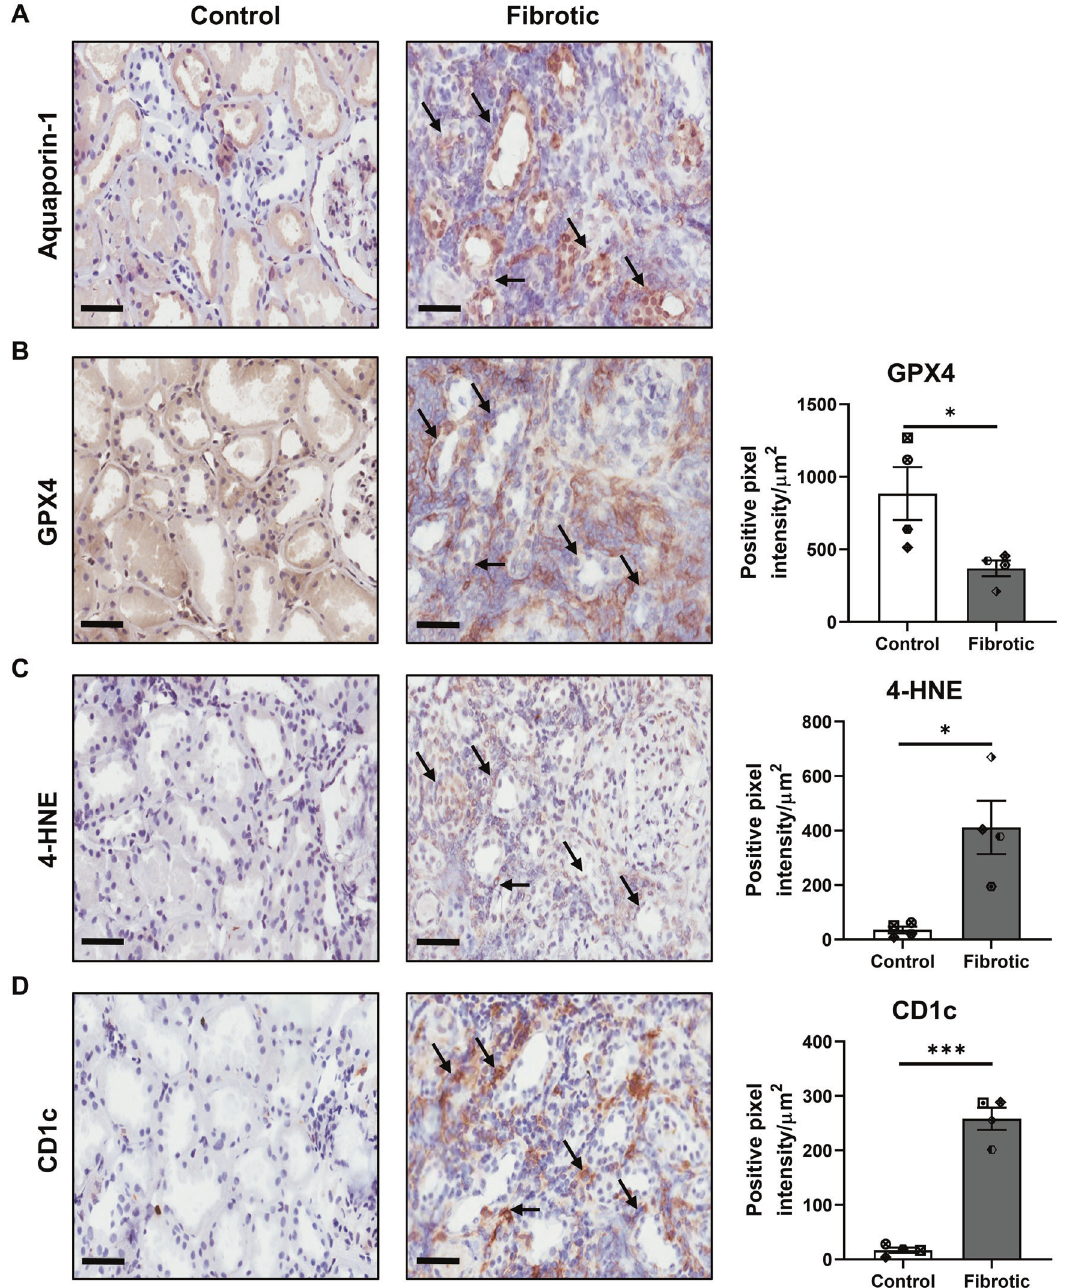
Fig. 3 Co-localisation of human CD1c + DC with ferroptotic PTEC in fi brotic kidney tissue. Representative serial section immunohistochemical (IHC) staining of control/non- fi brotic (left panel) and fi brotic (middle panel) kidney tissue probed for ( A ) aquaporin- 1, ( B ) GPX4, ( C ) 4-HNE and ( D ) CD1c. Regions of CD1c + DC co-localisation with aqupaporin-1 + PTEC displaying evidence of ferroptotic cell death ( ↓ GPX4 and ↑ 4-HNE) are highlighted with black arrows. Scale bars represent 60 µm. Quantitative analysis (positive pixel intensity/µm 2 total area) of IHC staining in control and fi brotic tissue is presented (right panels). Symbols represent values for individual donor tissue. Results represent mean ± SEM of values from four randomly selected areas for each tissue sample. * P < 0.05, *** P < 0.001, Welch ’ s t